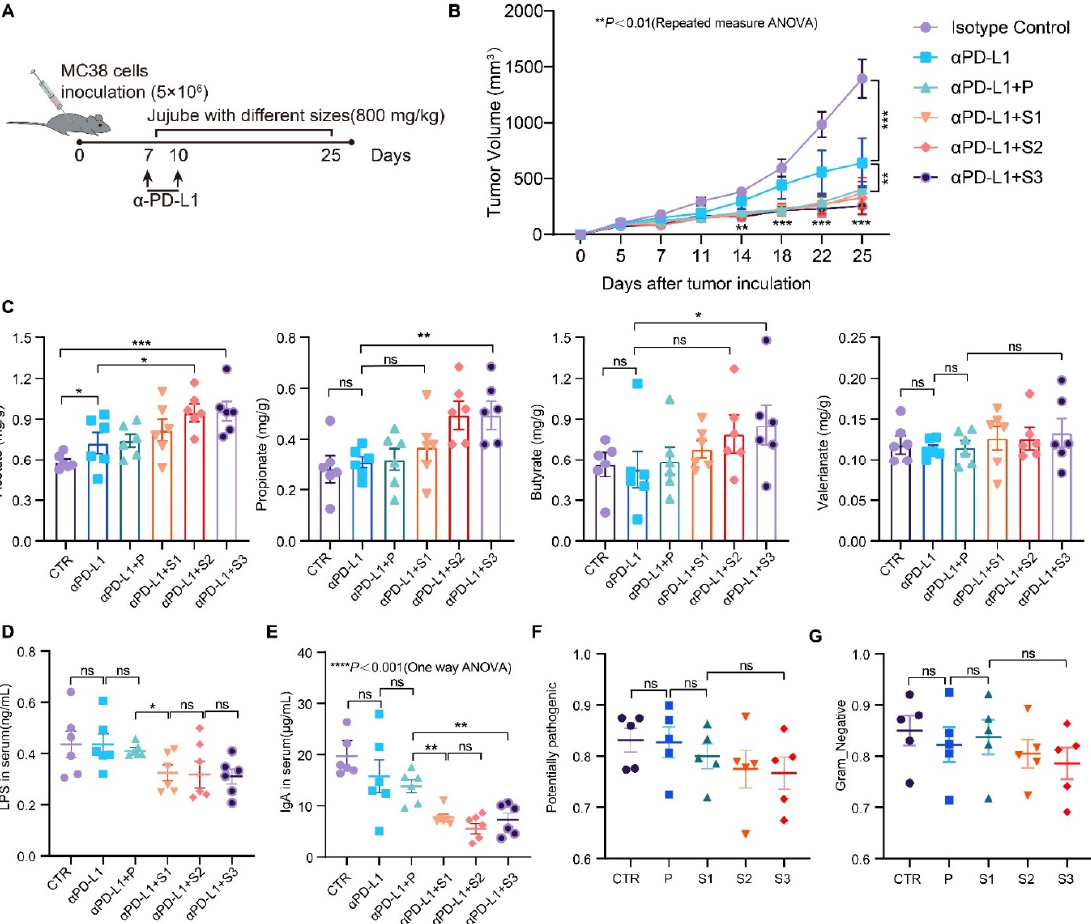
Figure 5. A reduction in JP particle size enhances its efficiency for anti-PD-L1 therapy. ( A ) Animal experiment design; ( B ) growth curve of tumor cells; ( C ) SCFA contents in cecum; ( D ) concentration of LPS in serum; ( E ) concentration of IgA in serum; ( F ) BugBase predicted potentially pathogenic and Gram-negative bacteria ( G ) in the microbial communities ( n = 6). Data indicate the mean ± SEM; * p < 0.05, ** p < 0.01, *** p < 0.001.